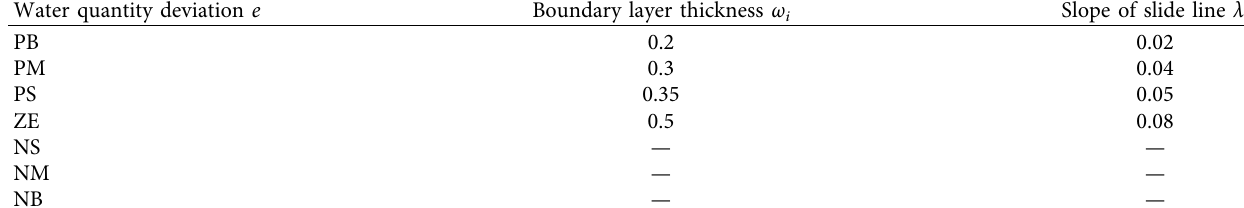
Table 1: Rules of the fuzzy sliding mode